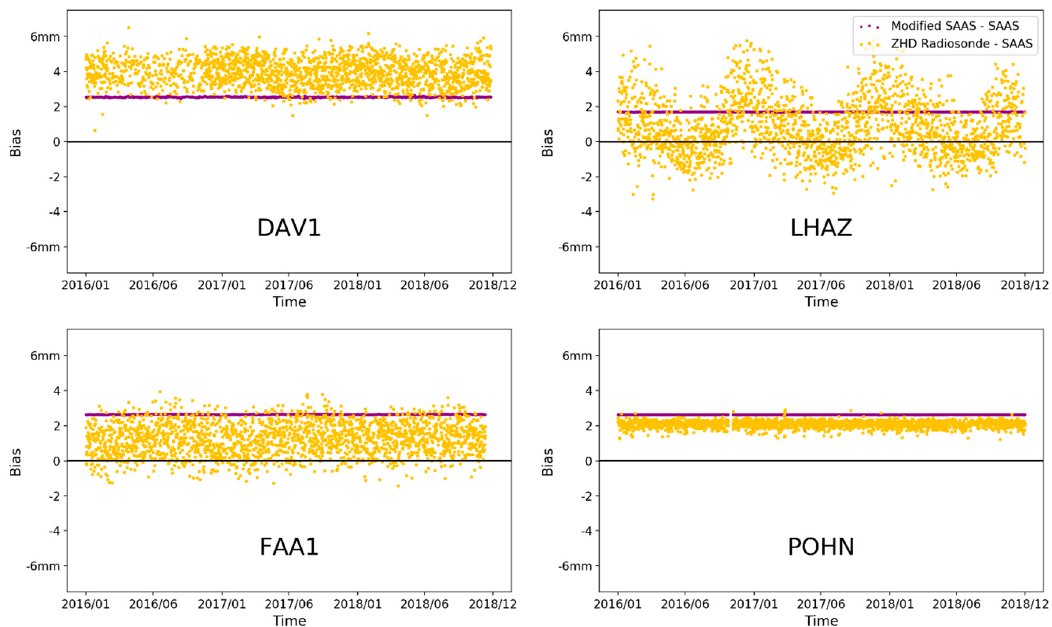
Figure 4. Example of modified Saastamoinen ZHD estimates (purple) and radiosonde derived ZHD estimates (yellow) biases, with respect to Saastamoinen ZHD estimates. The station DAV1 is located on the Antarctica coast, LHAZ is on the Tibet plateau, FAA1 is located on Tahiti island, and POHN is on Pohnpei island of the Federated States of Micronesia.